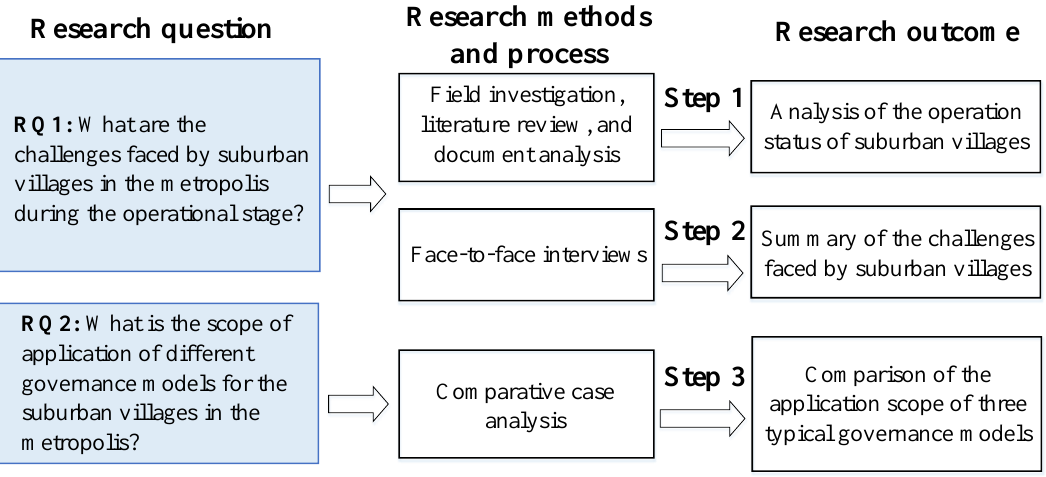
Figure 2. Analytical framework.